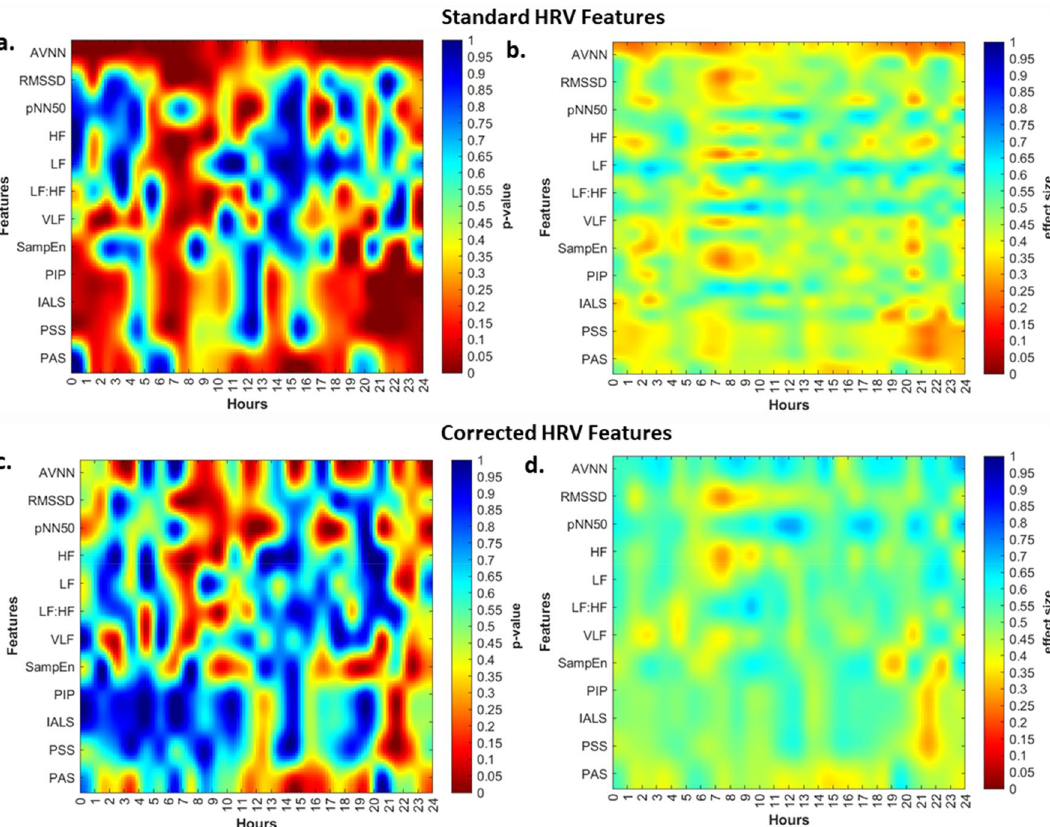
Figure 2. One-hour Window analysis for 24-h HRV Signal. Heat maps of p value and effect size for one-hour window analysis between BB and NBB group for HFpEF for standard and corrected HRV. ( a ) p values for standard HRV measure. ( b ) Effect size for standard HRV measures. ( c ) p values for corrected HRV measure. ( d ) Effect size for corrected HRV